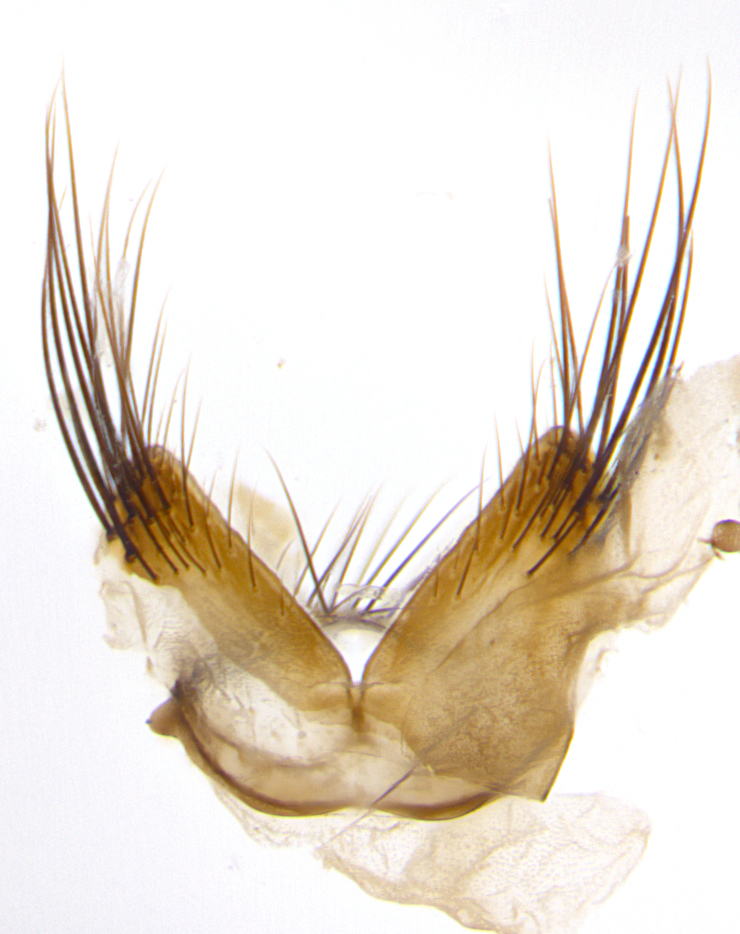
sternite 5, ventral view.